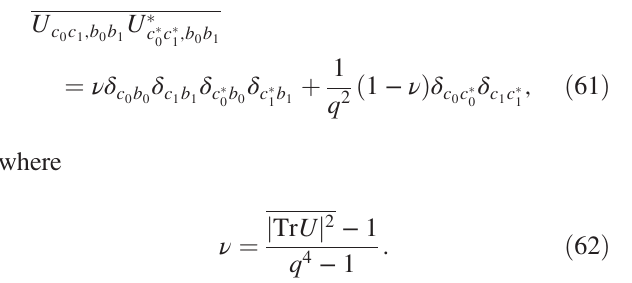
FIG. 26. Comparison of the deviations of Tr P t (solid lines) and ¯ K ð t Þ =t (dashed lines) from unity in Haar-RFCs with open boundary conditions. The system size L is shown on the